Question: Generate an informative caption for the figure above.
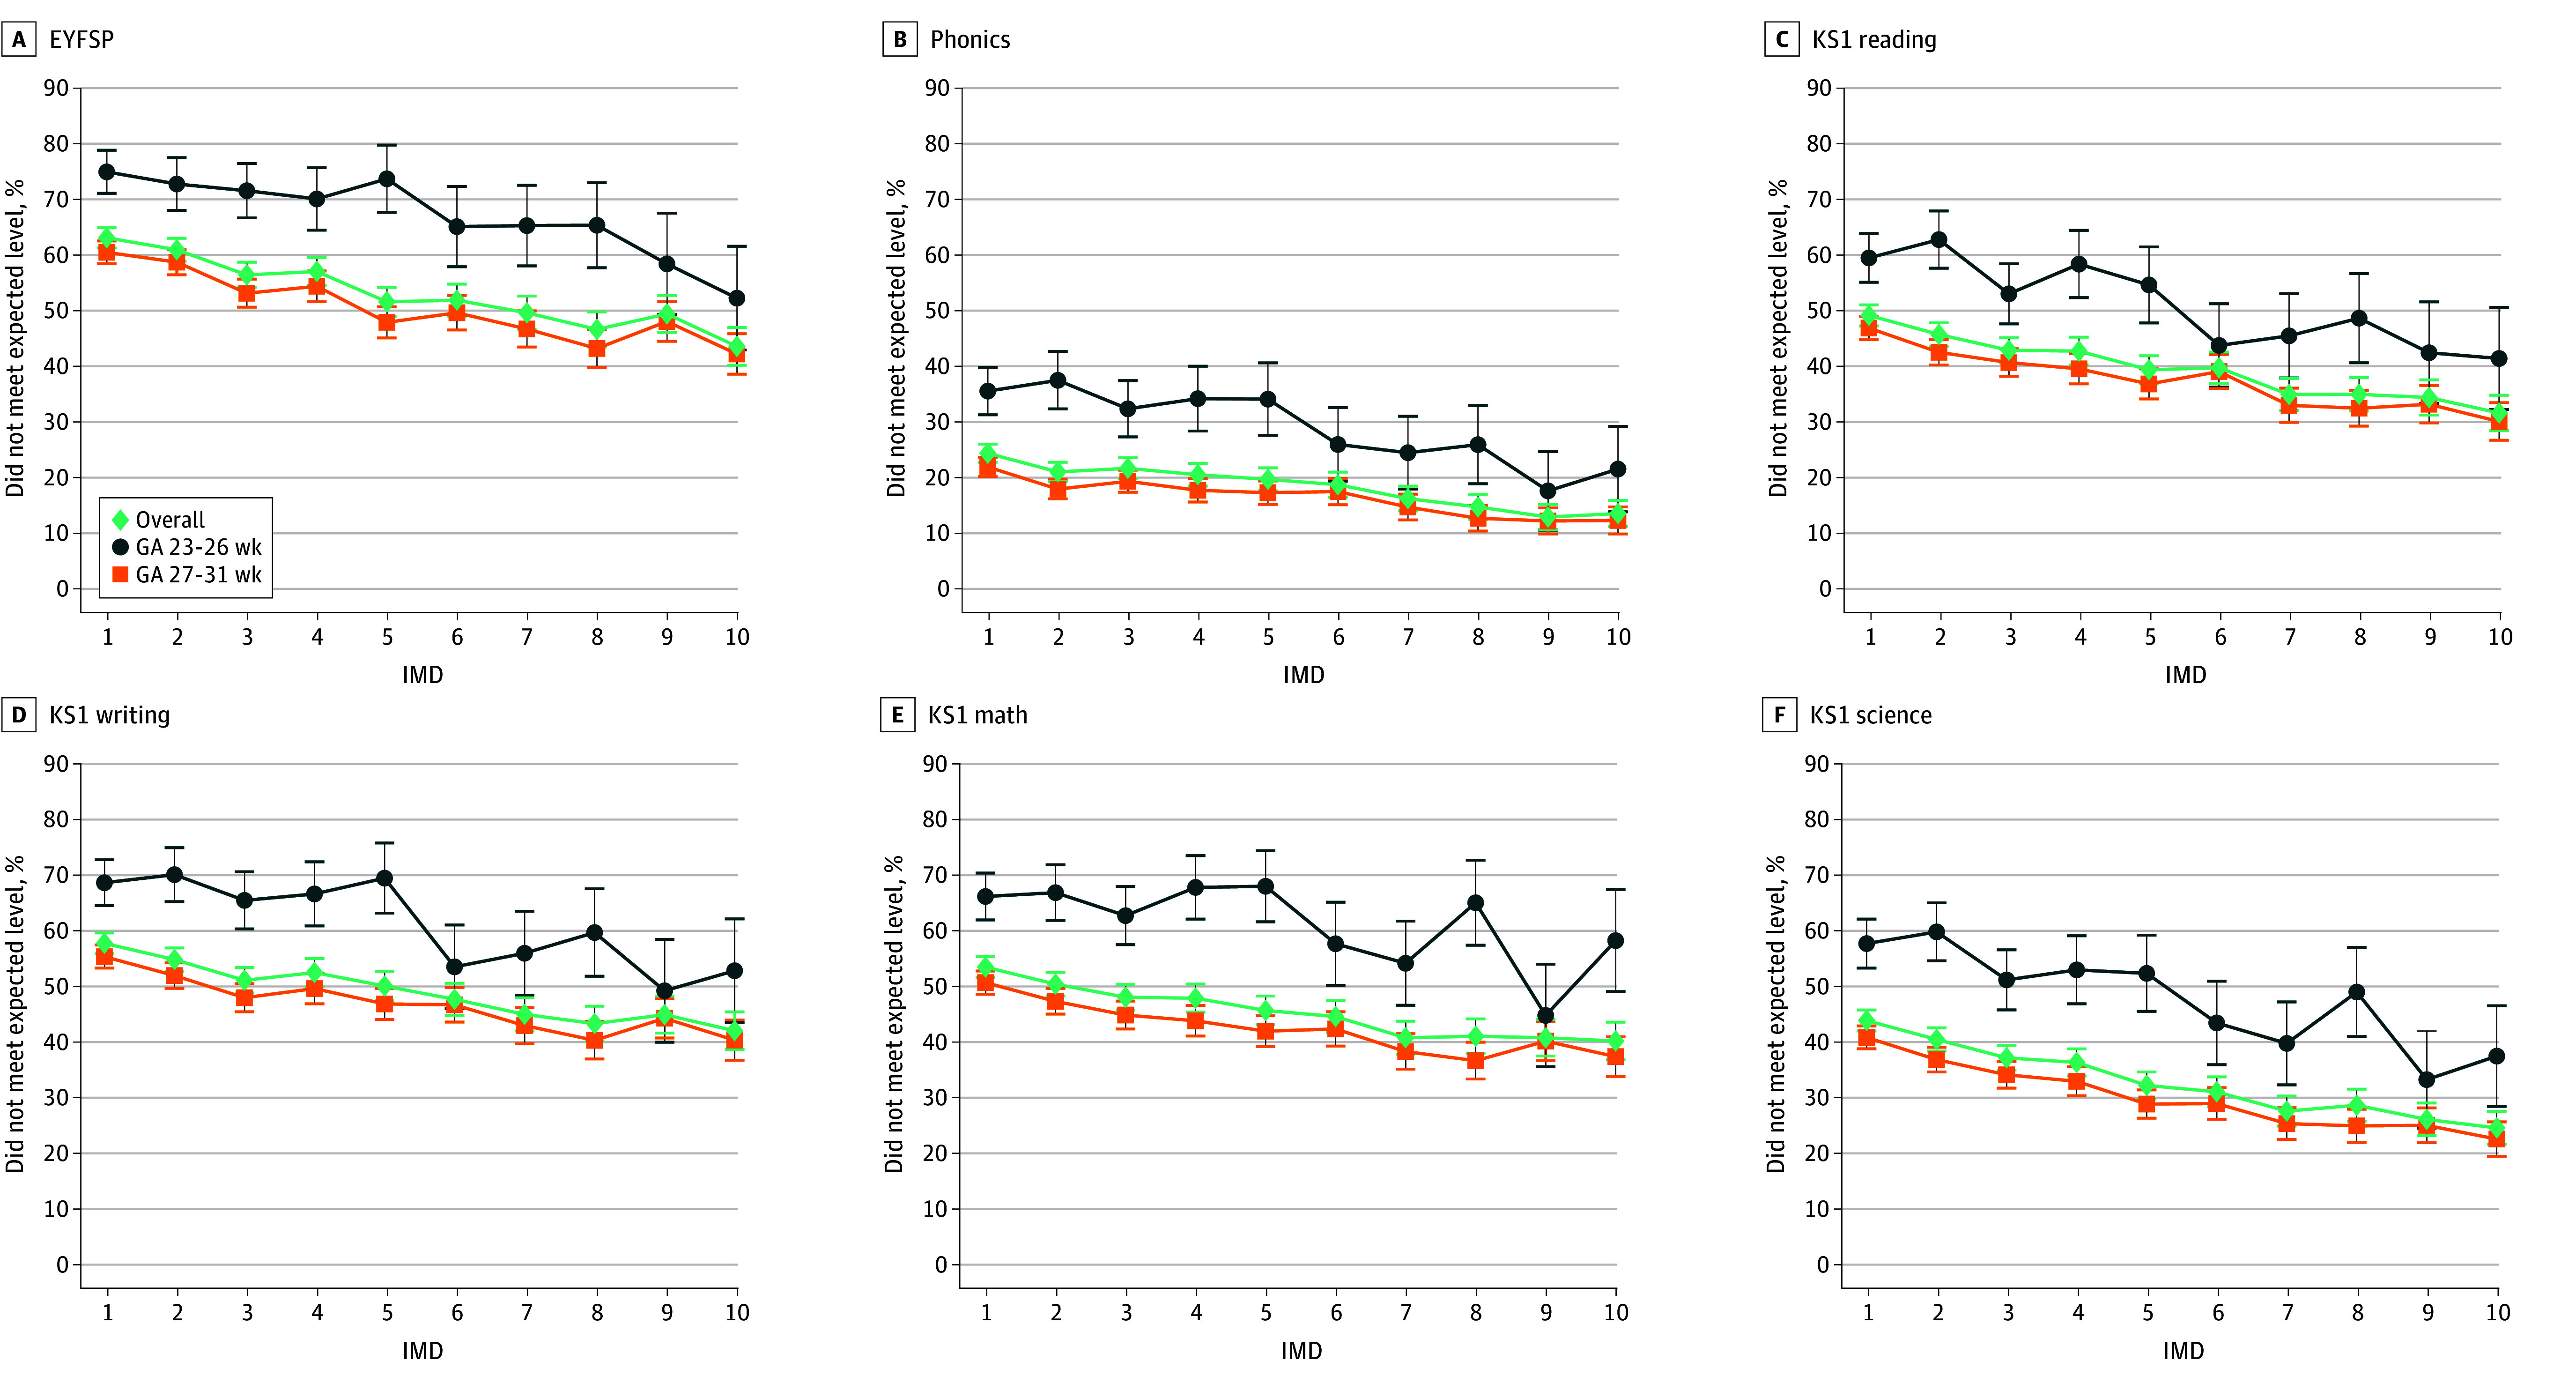
Answer: Dot Plots of the Proportion of Children Who Did Not Meet the Expected Level in Outcomes by Socioeconomic Status at Birth (Index of Multiple Deprivation [IMD]), Stratified by Gestational Age (GA) Category and the Overall Cohort Trend tested using the Cochran-Armitage test. P < .001 for every line. Error bars indicate the 95% CI. Index of Multiple Deprivation decile 1 indicates the most deprivation and decile 10, the least deprivation. EYFSP indicates Early Years Foundation Stage Profile; KS1, key stage 1.